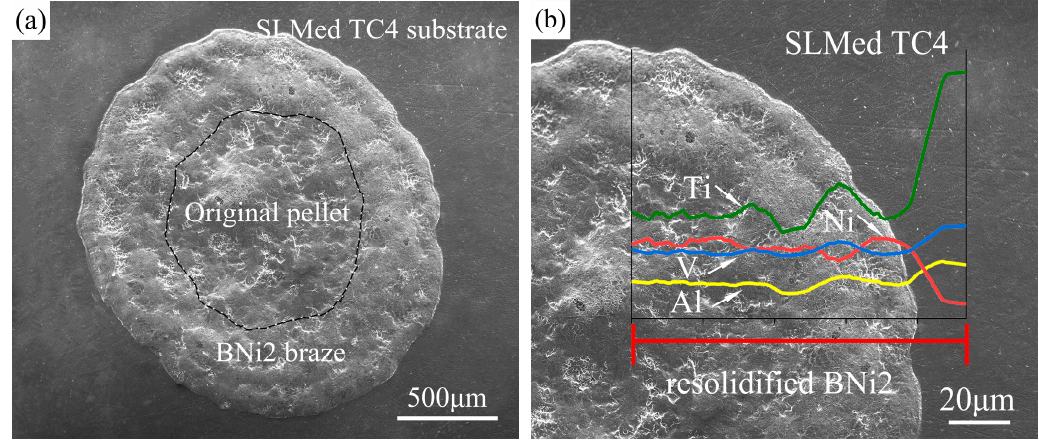
Figure 8. ( a ) A typical top view of the wetted sample; ( b ) the line scan analysis of the main element distribution from the center to the edge of the wetted sample.